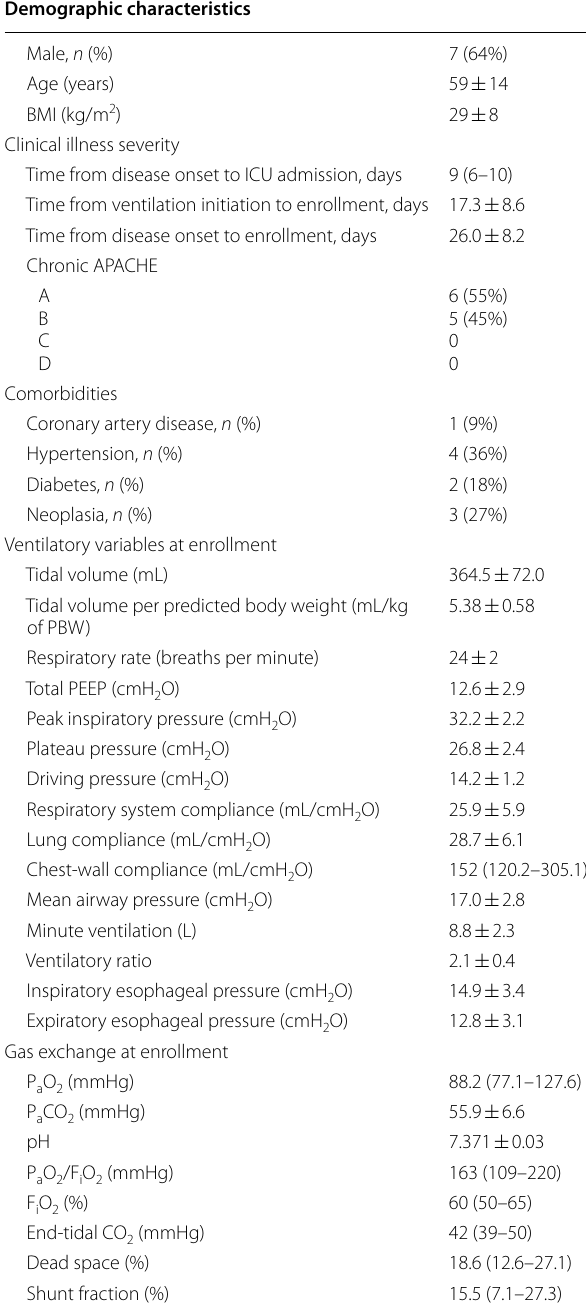
Table 1 Baseline demographic and clinical characteristics